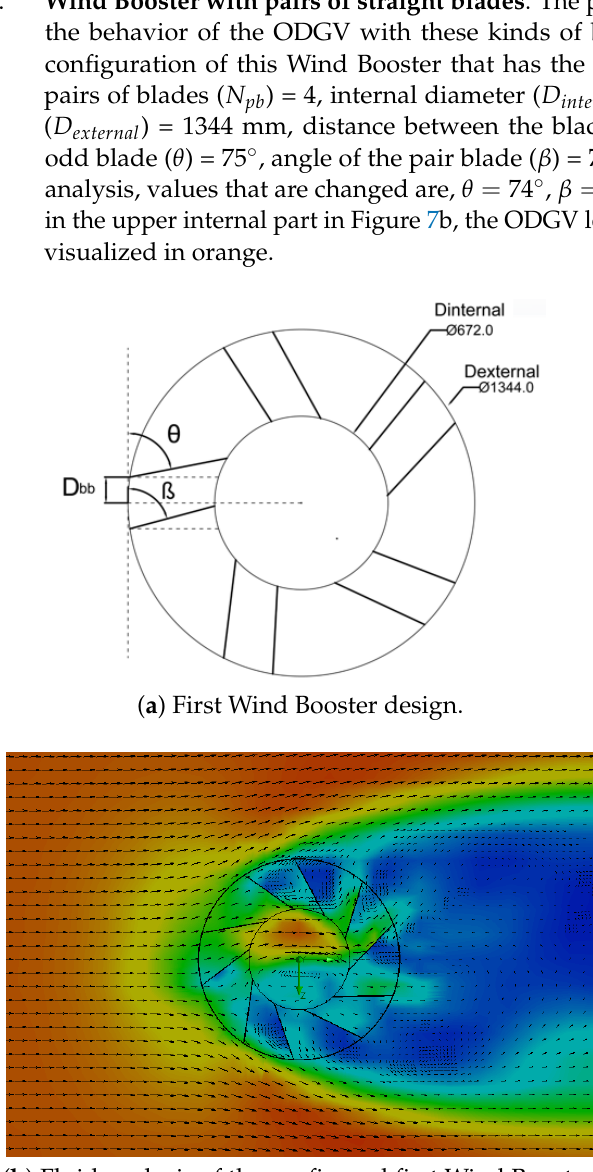
Figure 7. First Wind Booster